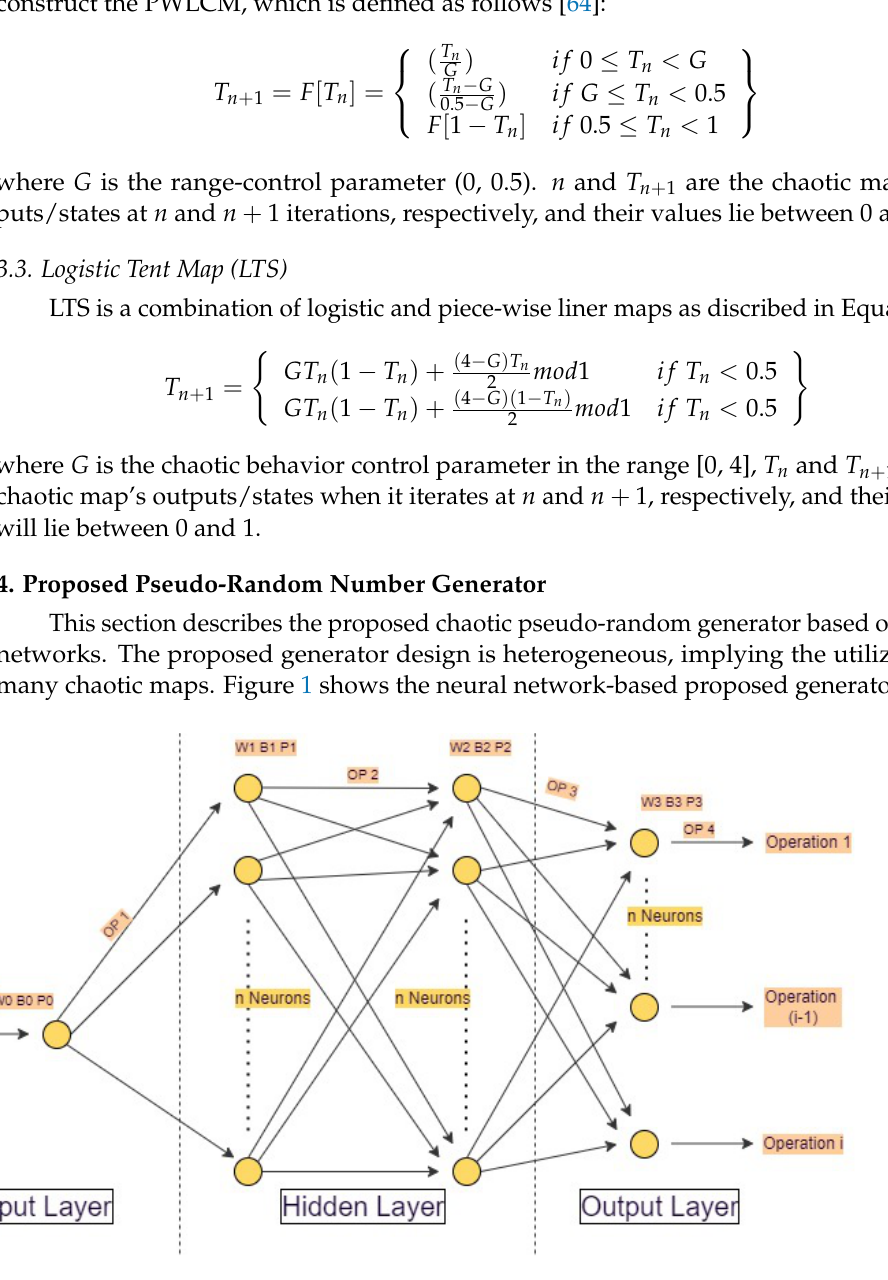
Figure 1. Neural network-based generator